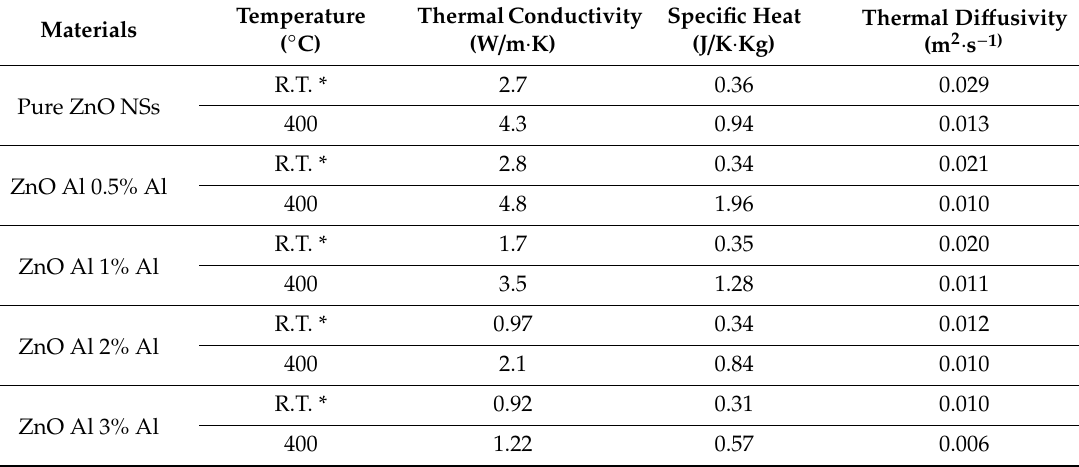
Table 3. Thermal conductivity measurements of pure ZnO NSs and Al doped